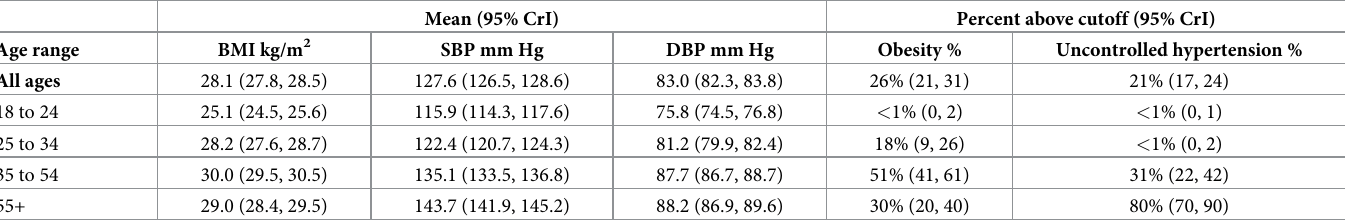
Table 2. Predicted SBP, DBP, BMI, and percentage of women classified as having obesity and uncontrolled hypertension among adult Accra women in the 2010 census (10% random sample) from hierarchical spatial Bayesian models.